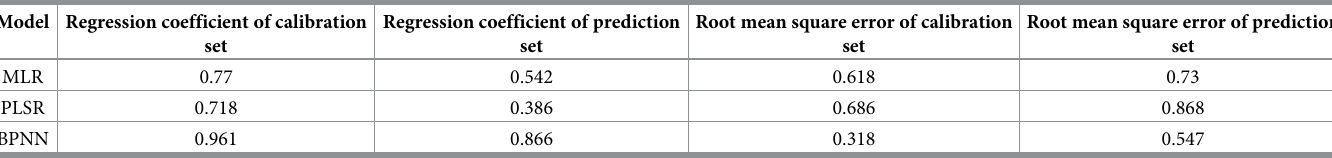
Table 5. Comparison of the prediction results of three models for